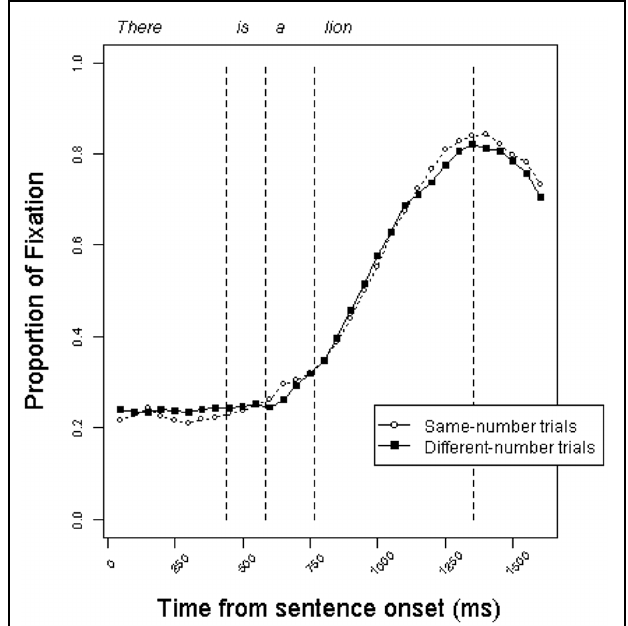
FIGURE 3 | Proportion of fixations to target objects in the indefinite condition on same-number vs. different-number trials in Experiment